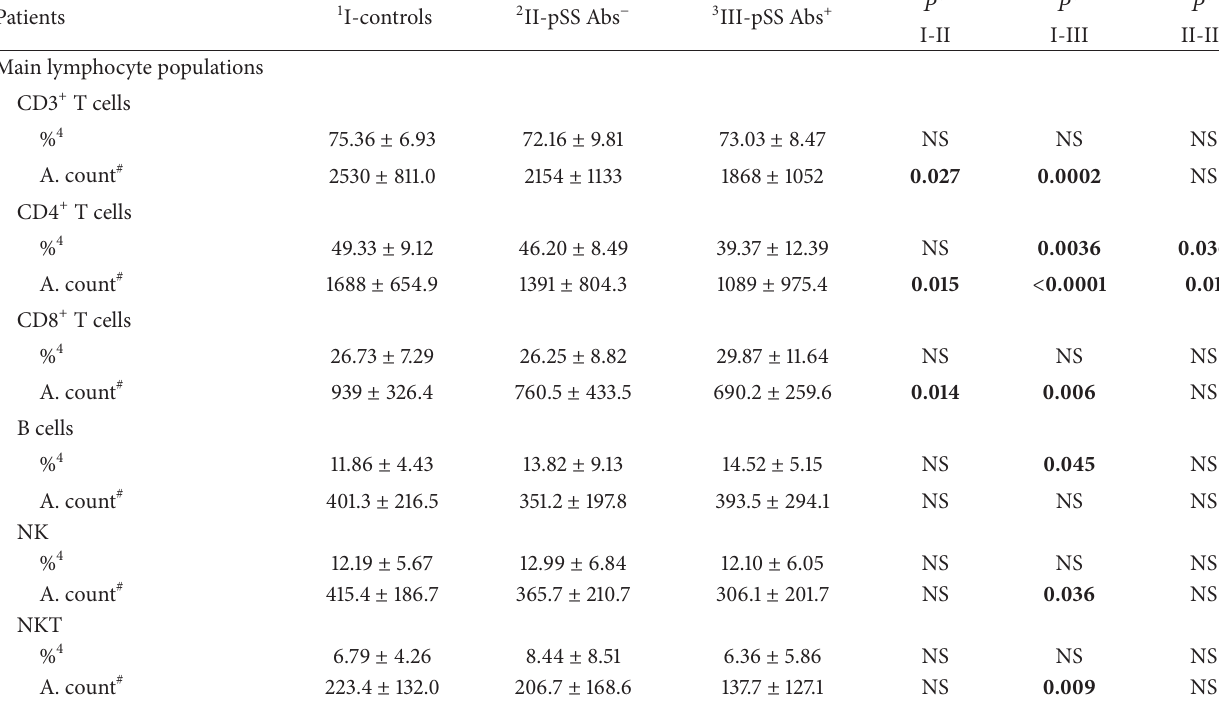
Table 2: Distribution of lymphocyte populations in peripheral blood of pSS patients and